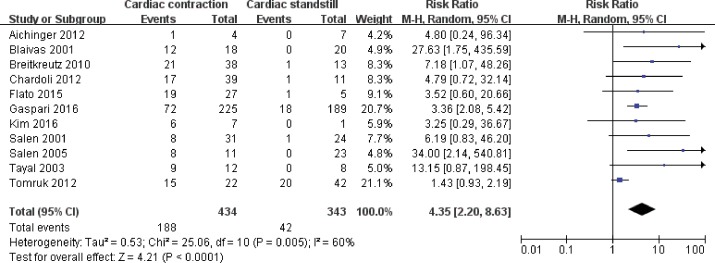
Forest plot of the pooling effects of cardiac activity on the restoration of spontaneous circulation.Pulseless electrical activity (PEA) can be sub-divided into pseudo-PEA and true-PEA according to the cardiac contraction or cardiac standstill on ultrasound (US).